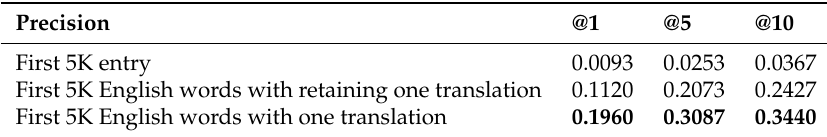
Table 5. English–Italian precision values with the different training sets.